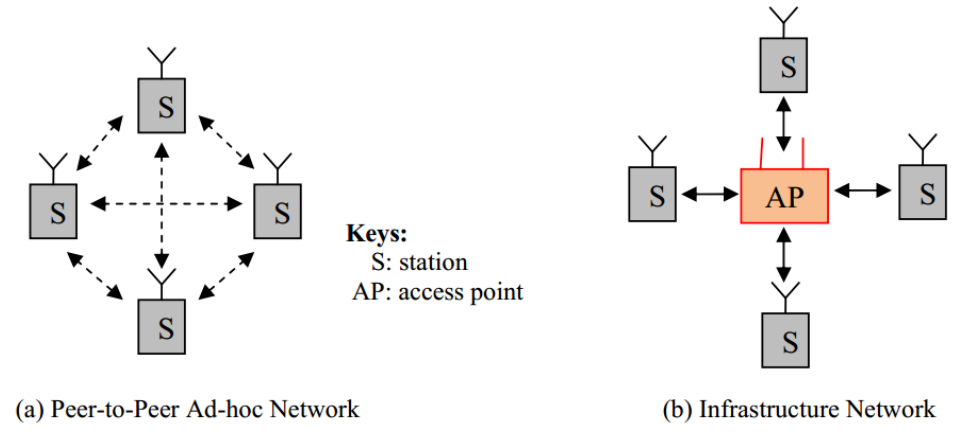
Figure 3. Examples of two possible types of Wi-Fi